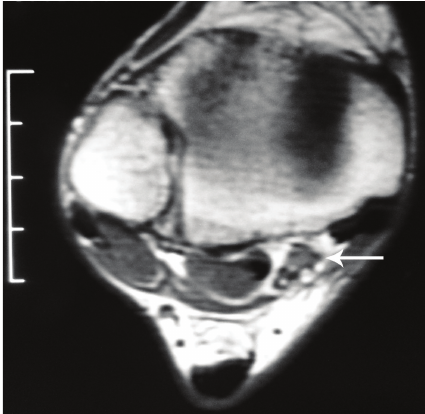
Figure 2: Accessory muscle (white arrow).